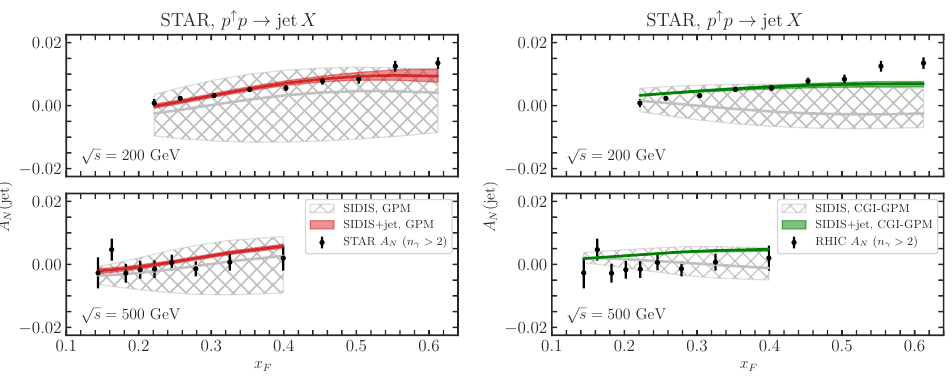
Figure 1: Results for the reweighting procedure from SIDIS and A GPM (left) and CGI (right) formalisms, compared with STAR measurements [ 14 ] at (cid:112) s = 200GeV (upper panels) and are at 2 σ CL. The results before (hatched grey bands) and after (solid red / green bands) reweighting are